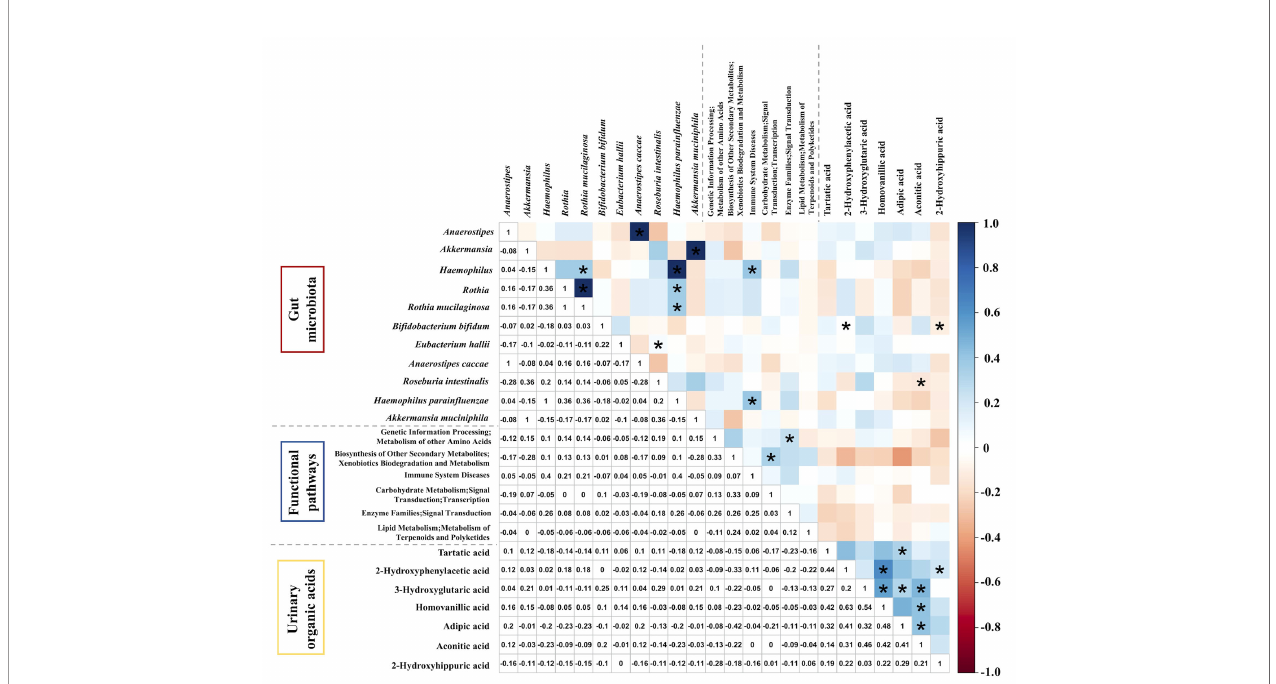
FIGURE 4 | The Spearman correlation matrix among gut microbiota, functional pathways, and urinary organic acids different in autistic children with and without atopic dermatitis. *P <